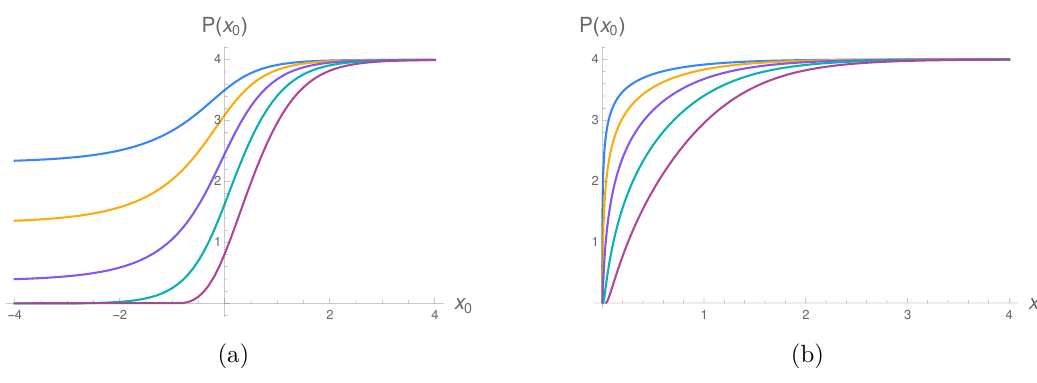
Figure 12. On the left P and on the right for y 0 = 0 , i.e. geodesics along the boundary of the strip. The curves show, from top to bottom, N 5 /K ∈ { 1